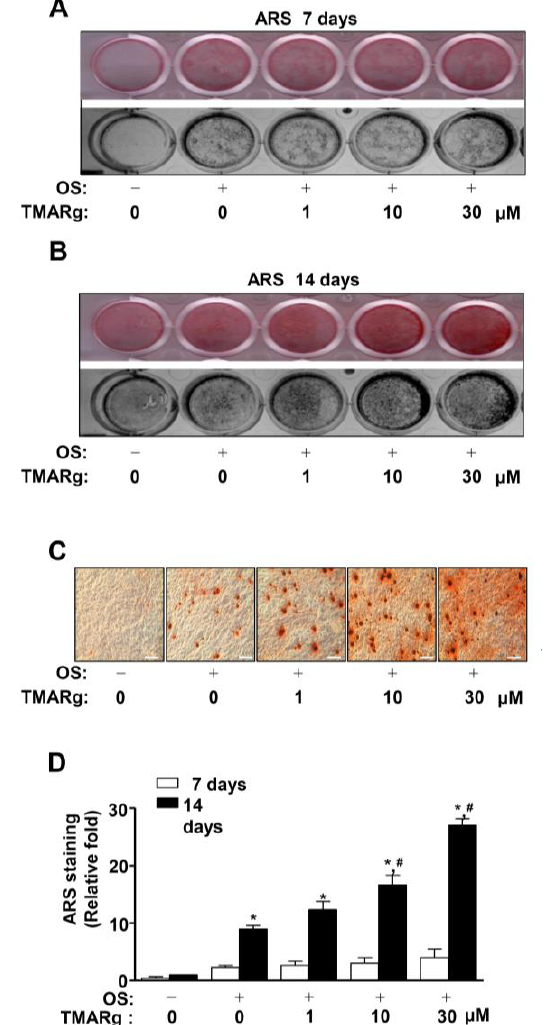
Figure 3. TMARg promotes late osteoblast differentiation. ( A – D ) Pre-osteoblasts were seeded onto 24-well plates and were cultured in OS with TMARg (0, 0.1, 1, 10, and 30 µM). Mineralized nodule formation was assessed by using ARS staining at 7 ( A ) and 14 days ( B ). The levels of ARS staining were observed using a scanner (upper) and a colorimetric detector (bottom) ( A , B ). Mineralization nodules were observed by using a light microscope ( C ). Stains were eluted with DMSO to quantify the intensity of ARS staining, and this quantification was performed by using the Multiskan GO Microplate Spectrophotometer. The data are represented as relative fold-increases of the control ( C ). The data are representative of the results of three independent experiments. Scale bar: 100 µm. Data represent the means ± SEMs of experiments. *, p < 0.05 was considered significantly di ff erent, compared to the control. #, p < 0.05 was considered significantly di ff erent, compared to the